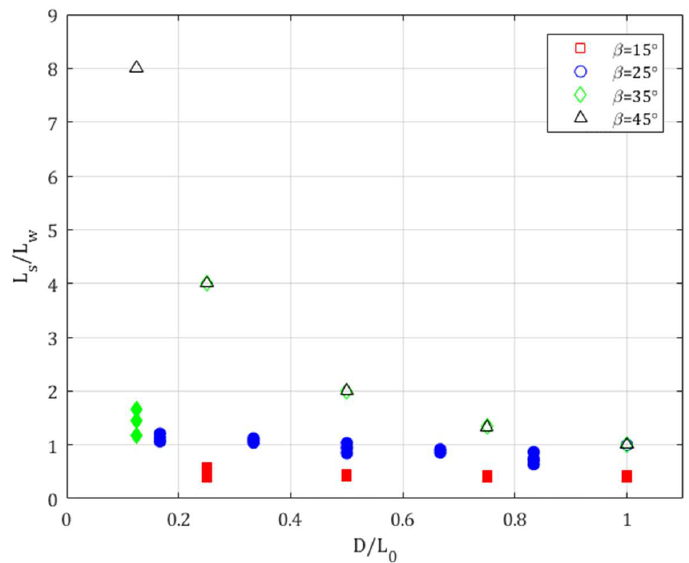
Figure 4. The ratio 𝐿 (cid:3046) /𝐿 (cid:3050) , where 𝐿 (cid:3046) is the separation length and 𝐿 (cid:3050) the width of the plume. For 𝛽 = 15° , the ratio has the constant value of ≈ 0.29 , while for 𝛽 = 25° , the ratio is of 𝑂(1) . The filled in markers represent data with separation 𝐿 (cid:3046) /𝐿 (cid:2868) < 1 , and empty markers represent cases with separation at the